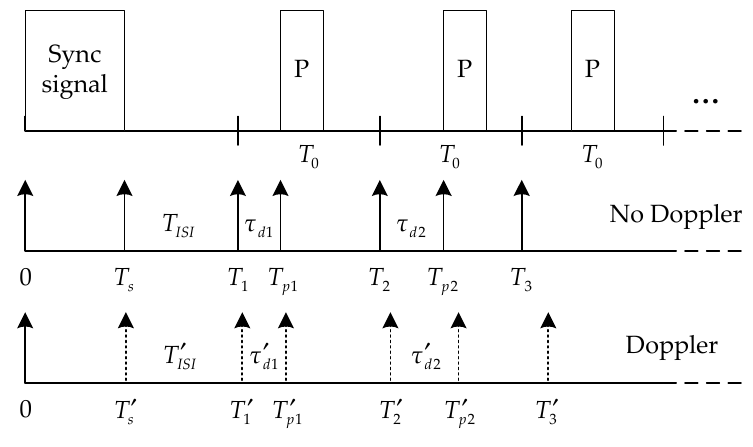
Figure 4. The diagram of decoding.